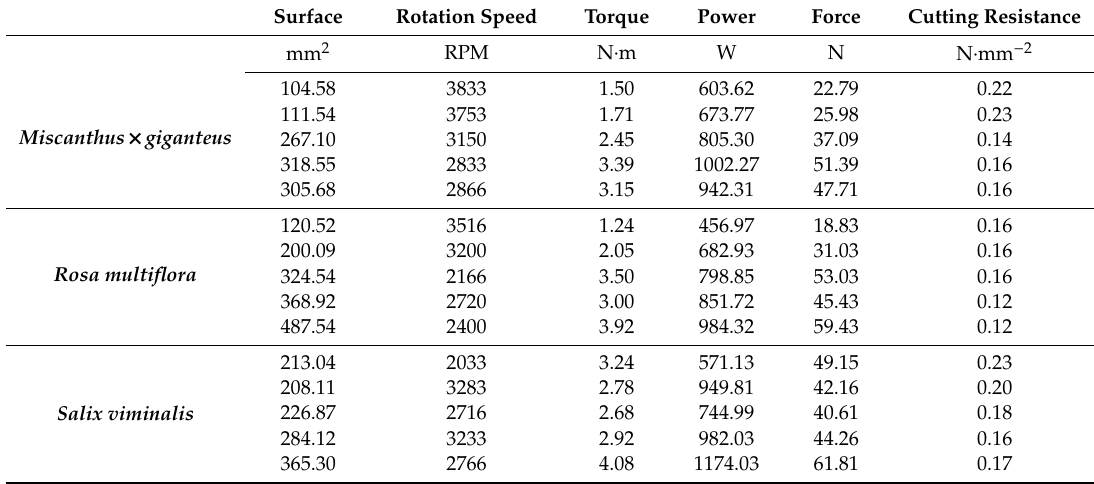
Table 4. The average cutting resistance at the initial rotation speed n 1 = 4200